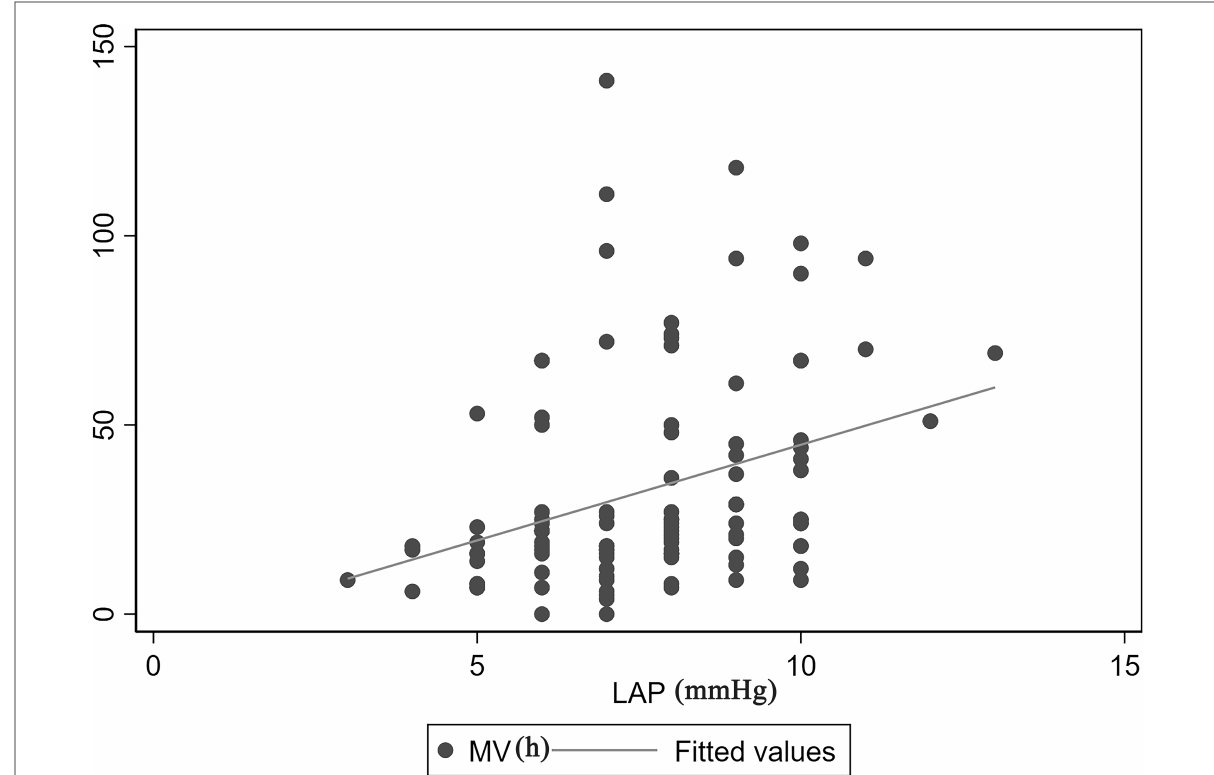
FIGURE 2 Correlation between MV time and LAP. There was a positive linear correlation between MV time and LAP (Spearman correlation coef fi cient=0.41, P < 0.01). LAP, left atrial pressure; MV, mechanical